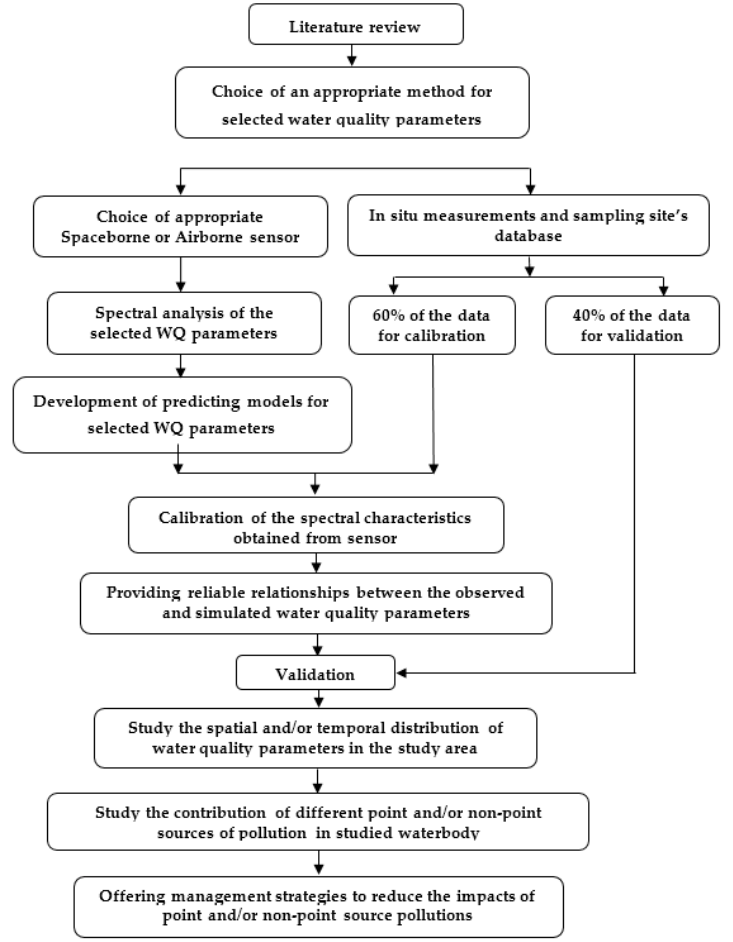
Figure 4. A suggested remote sensing based framework to predict and assessment of water quality variables.